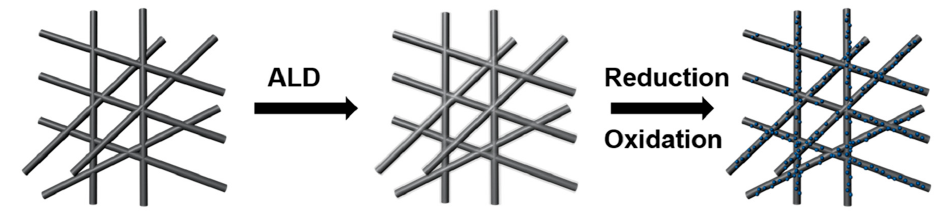
Figure 1. The schematic outline for the NiO/Ni nanoparticles deposited on carbon fiber paper. ALD: atomic layer deposition.